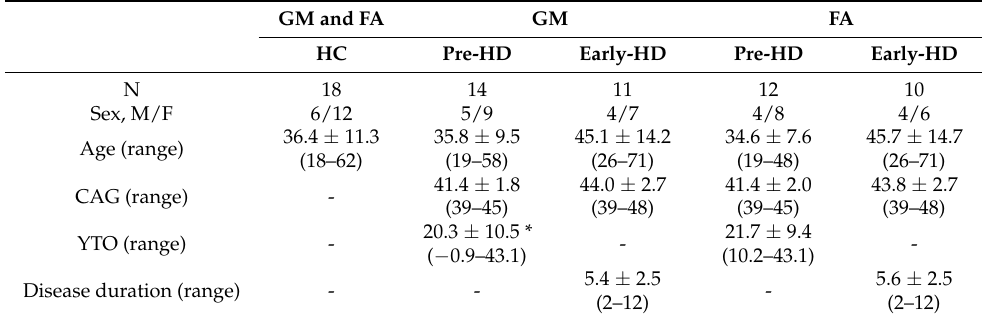
Table 1. Demographics of the three groups of participants (Mean ± SD). GM and